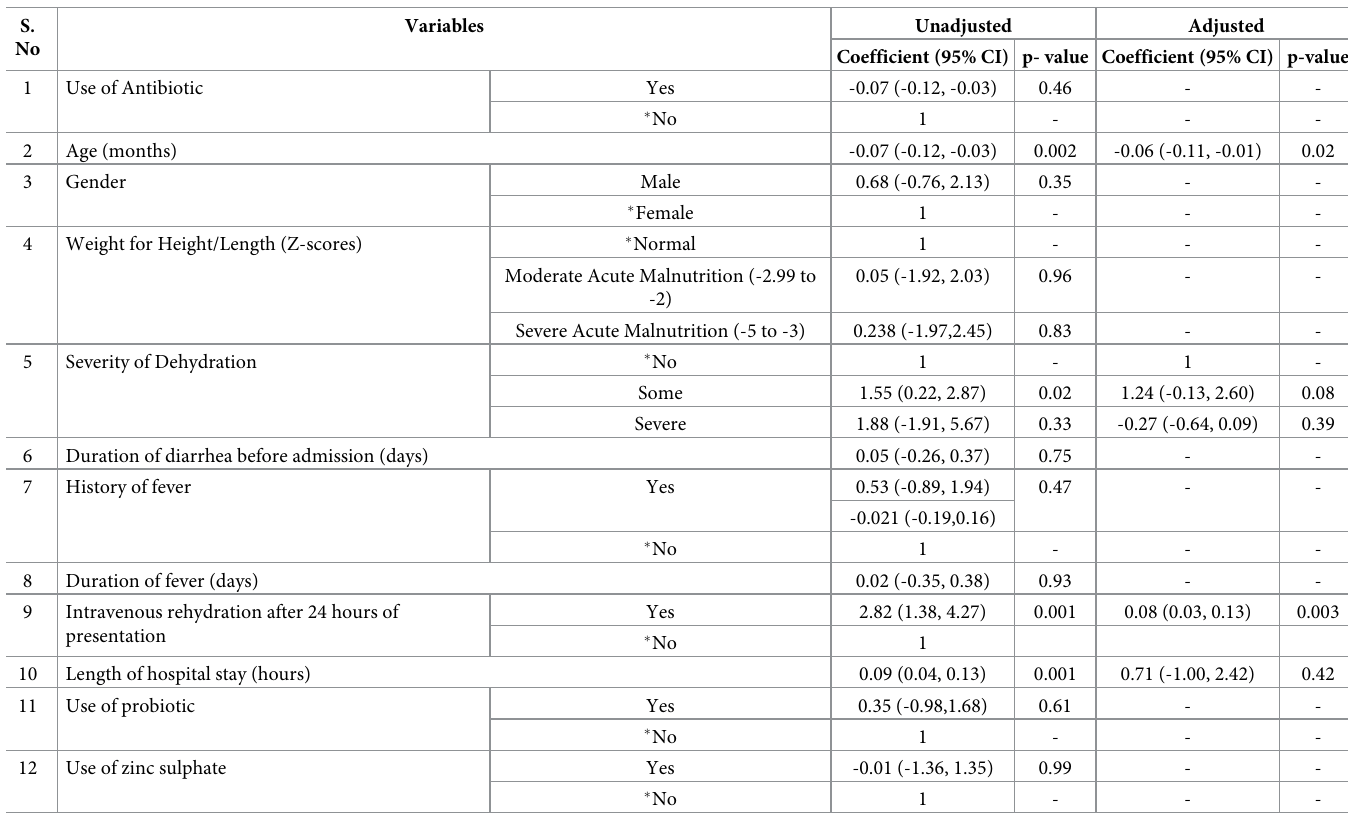
Table 3. Unadjusted and adjusted analysis of clinical characteristics and number of diarrheal episodes within 36 hours of presentation in children presented with acute watery diarrhea in a tertiary care hospital. S.